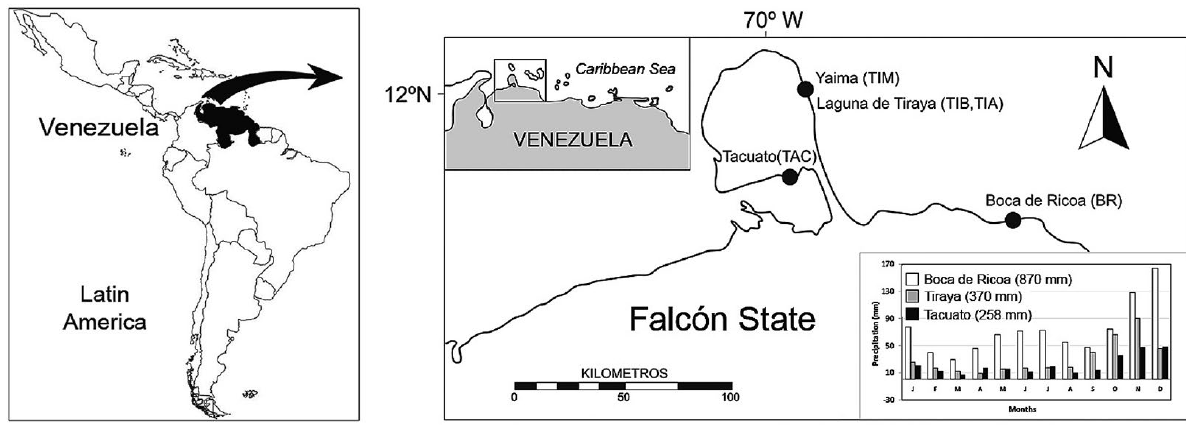
Fig. 1. – Geographic localization of Venezuela. Relative location of Falcón State (Venezuela). Black solid dots show the sampling sites for Aratus pisonii . Yaima (TIM: 12°03 ′ 10 ″ N - 69°51 ′0 9 ″ W), Laguna de Tiraya (TIB: 12°01 ′ 53 ″ N - 69°51 ′ 15 ″ W; TIA: 12°02 ′ 05 ″ N - 9°50 ′ 48 ″ W)